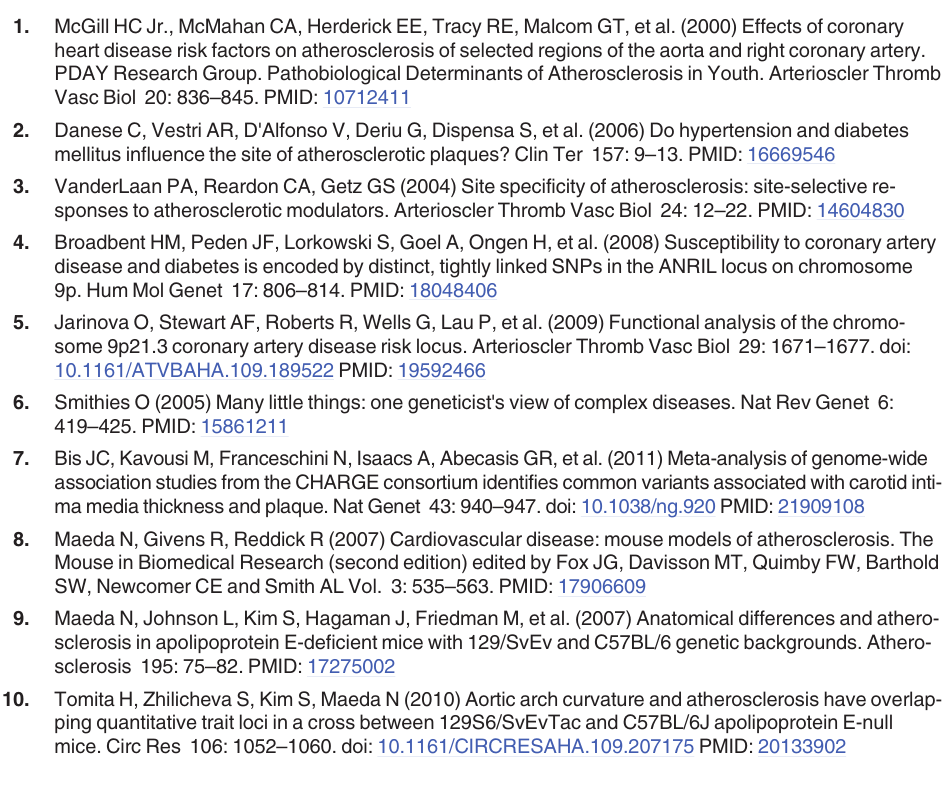
phenotypes of knockout or mutant mice are shown. Ratios between two strains that show sig- nificant difference in the expression are bolded. AA substitutions that are predicted to be dele- terious by SIFT and/or Polyphen2 programs are bolded (see S5 Table). a P < 0.05. S10 Table. Haplotype analysis of Aath5 on Chr 10. Genes with DBA-unique sequences (DBA 6¼ B6, 129) within and near the interval of 30 – 101 Mb are shown. For each gene, expres- sion ratios in the aorta and macrophages, expression levels in 129, amino acid (AA) differences (B6, 129-position-DBA), associations with atherosclerosis indicated by GWAS data, and pheno- types of knockout or mutant mice are shown. Ratios between two strains that show significant difference in the expression are bolded. AA substitutions that are predicted to be deleterious by SIFT and/or Polyphen2 programs are bolded (see S6 Table). a P < 0.05, b P < 0.01, c P <